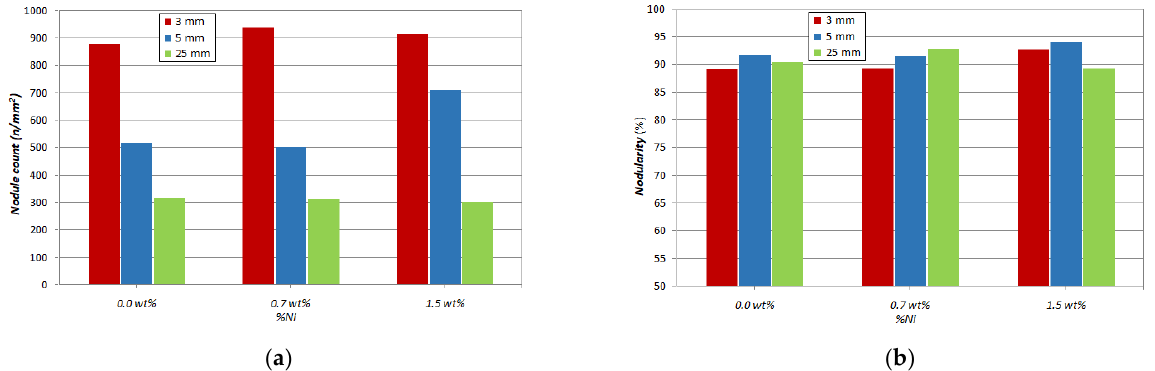
Figure 4. Graphite microstructure parameters vs. thickness and Ni content: ( a ) nodule count (number of nodules/mm 2 ); ( b ) nodularity (%). of nodules/mm 2 ); ( b ) nodularity